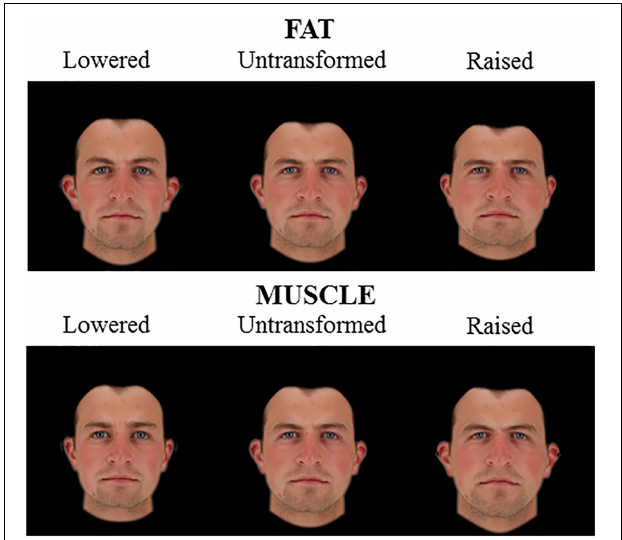
FIGURE 3 | 2D Male face shape associated with fat mass (top) and muscle mass (bottom). Individual faces (middle) were transformed to reflect face shapes associated with less fat/muscle mass (–4 BMI units, left) or more fat/muscle mass (+4 BMI units, right) based on the difference in the face shape between low and high fat/muscle prototypes for the independent 2D face set. The participant gave written informed consent for the publication of his image and use in the experiments.